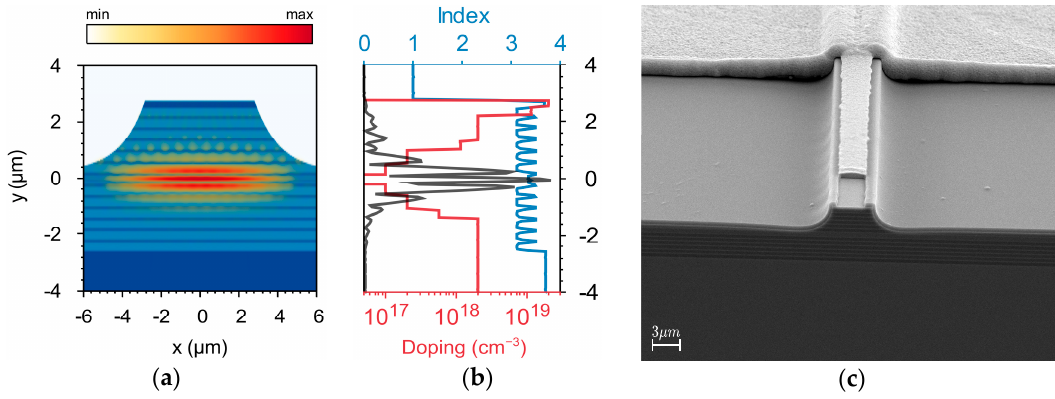
Figure 1. ( a ) Simulated intensity profile for the Bragg mode within the waveguide; ( b ) Refractive index and doping profile of the device; the Bragg mode has a higher overlap with the quantum well than the TE 00 mode; ( c ) SEM image of the sample showing the facet of the sample and the upper electrode with the thick electrolytic layer.